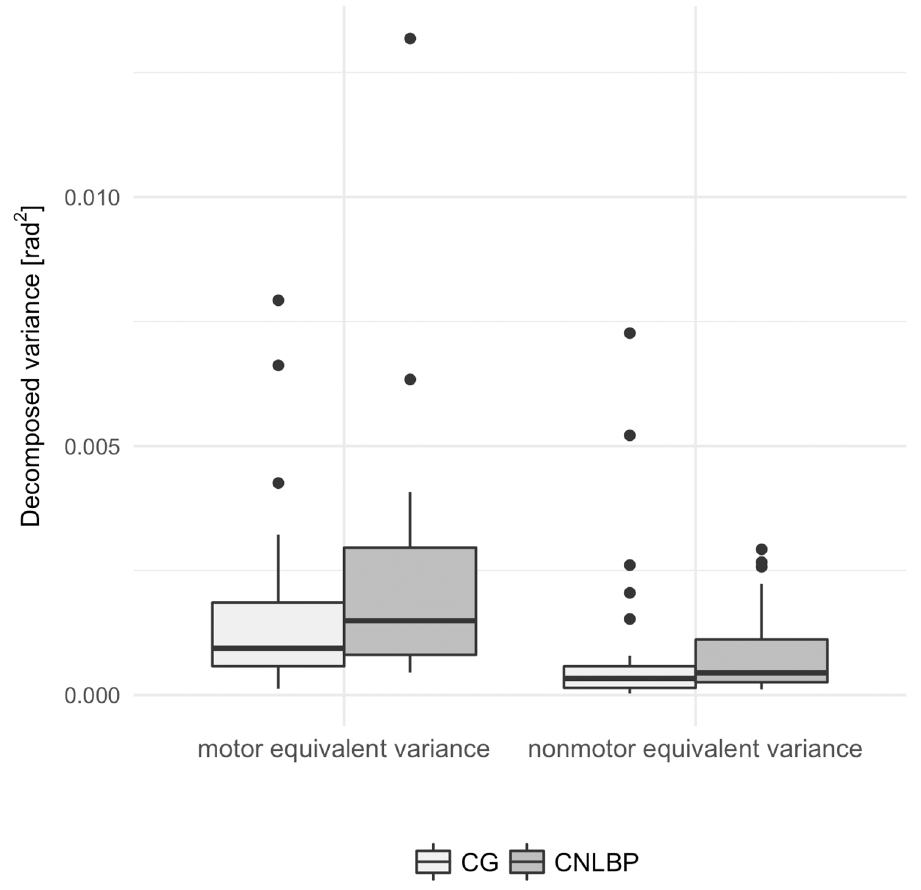
Fig 5. Group comparison of variance components. Across trials mean variance components during the first second of the active response phase after platform release. CG = control group; CNLBP = Chronic non-specific low back pain group.